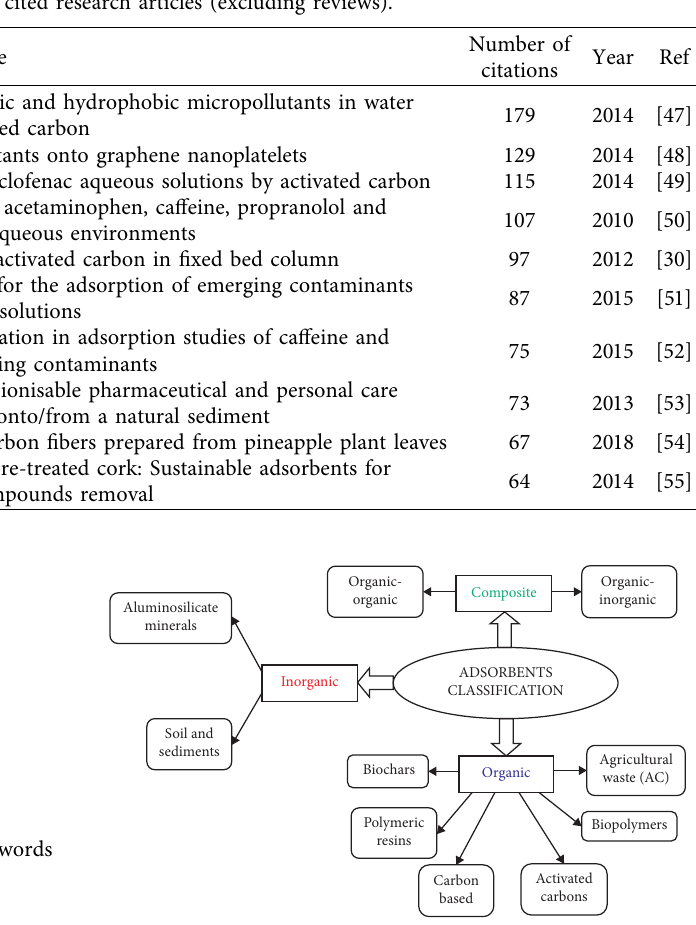
Figure 4: Classification of adsorbents for caffeine